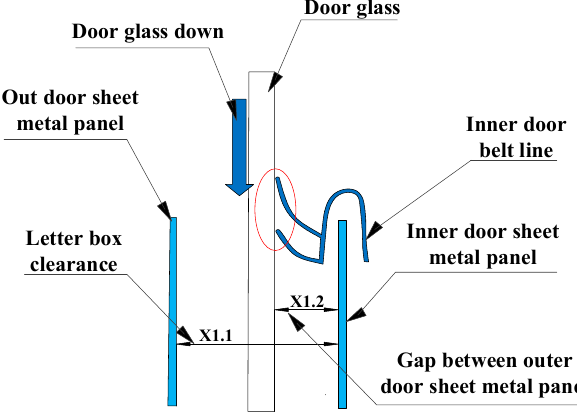
Figure 11. Structure diagram of the window.